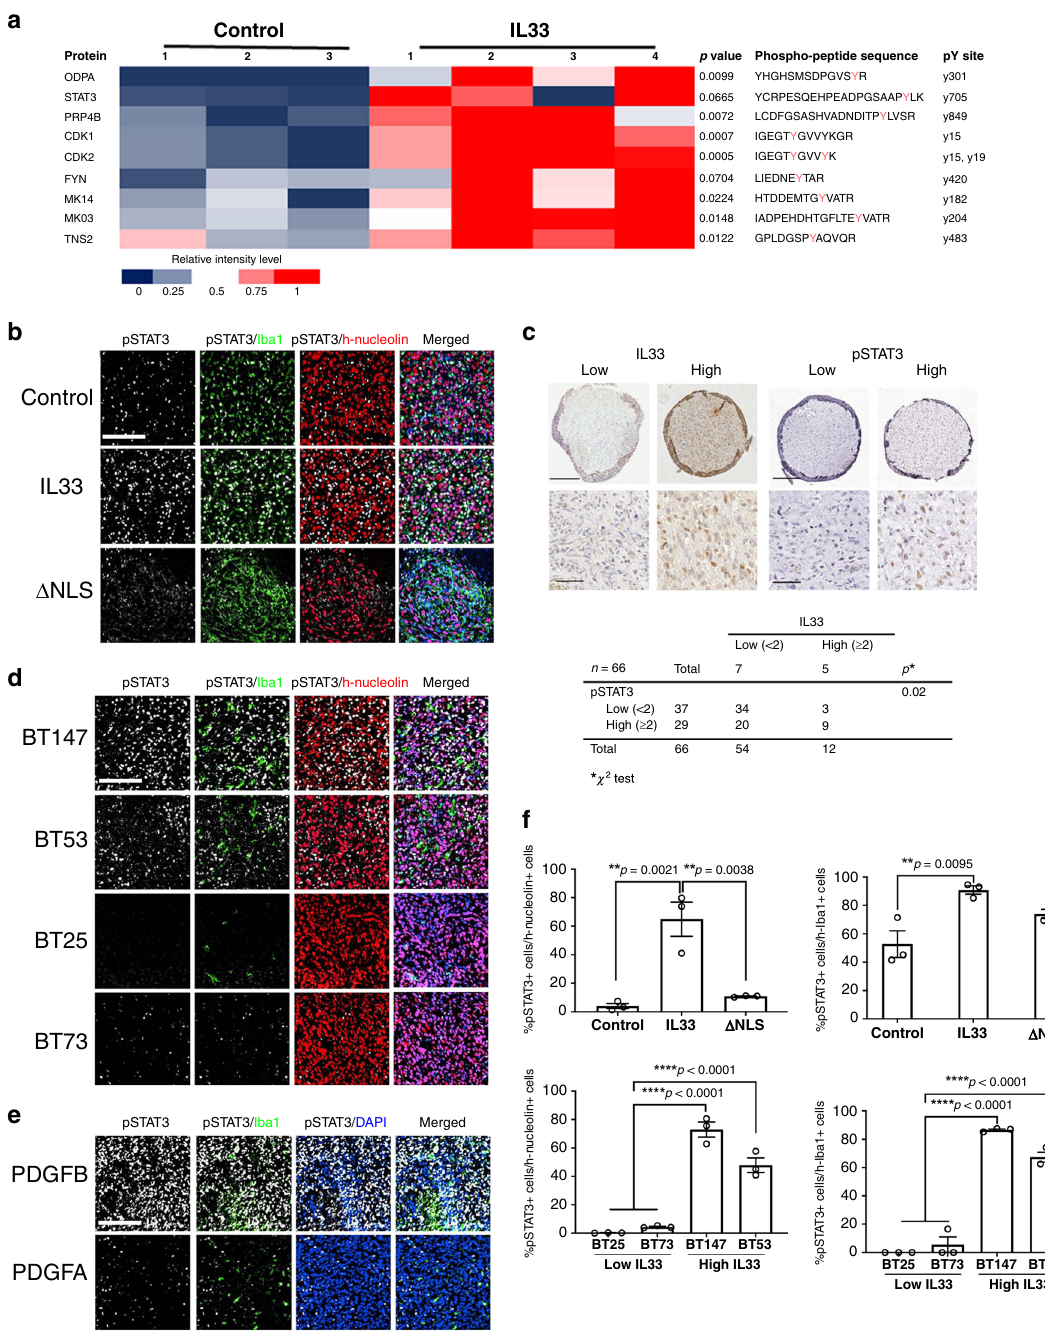
Fig. 8 Phosphoproteomic characterization of IL-33-expressing xenograft. a Comprehensive protein-pY analysis was performed on intracranial tumors from mice bearing IL-33 − (control; N = 3) or IL-33 + (IL-33; N = 4) U87-tumors. Heat map shows pY-peptides enriched in the IL-33 + tumors. The p -values were obtained by two-sided unpaired Student ’ s t -test. b Shown are representative immuno fl uorescence images of pSTAT3 (white), Iba1 (green), and human nucleolin (red) in xenografts from IL-33 − (control), IL-33 + (IL-33), or Δ NLS U87 tumor-bearing mice. Scale bar: 30 µ m. c IHC of a tissue microarray (TMA) containing 66 glioblastoma patient specimens was assessed for IL-33 (left panel; brown) and pSTAT3 (right panel; brown). TMA was counterstained using hematoxylin (blue). Shown are representative images of IL-33 high and low expressing tumors. Scale bar, 200 µ m (upper panels) and 50 µ m (lower panels). TMA was scored and assessed for an association between IL-33 and pSTAT3 expression. The p -value was based on the chi-squared ( χ 2 ) test. d Shown are representative images of Multiplex IF of pSTAT3 (white), Iba1 (green), and human nucleolin (red) in BT147, BT53, BT25, and BT73 xenografts. Scale bar 30 µ m. e Shown are representative images of Multiplex IF of pSTAT3 (white), Iba1 (green), and DAPI (blue) in PDGFB, PDGFA, and shNF1-driven mouse glioma. Scale bar: 30 µ m. f Quanti fi cation shows the percentage of pSTAT3 + cells as compared to the total number of human nucleolin or Iba1 + cells. Data are mean ± SEM from six independent fi elds of view from 3 mice/group; ** p ≤ 0.01, **** p ≤ 0.0001 by one-way ANOVA with Tukey ’ s post hoc test. Source data are available as a Source data fi